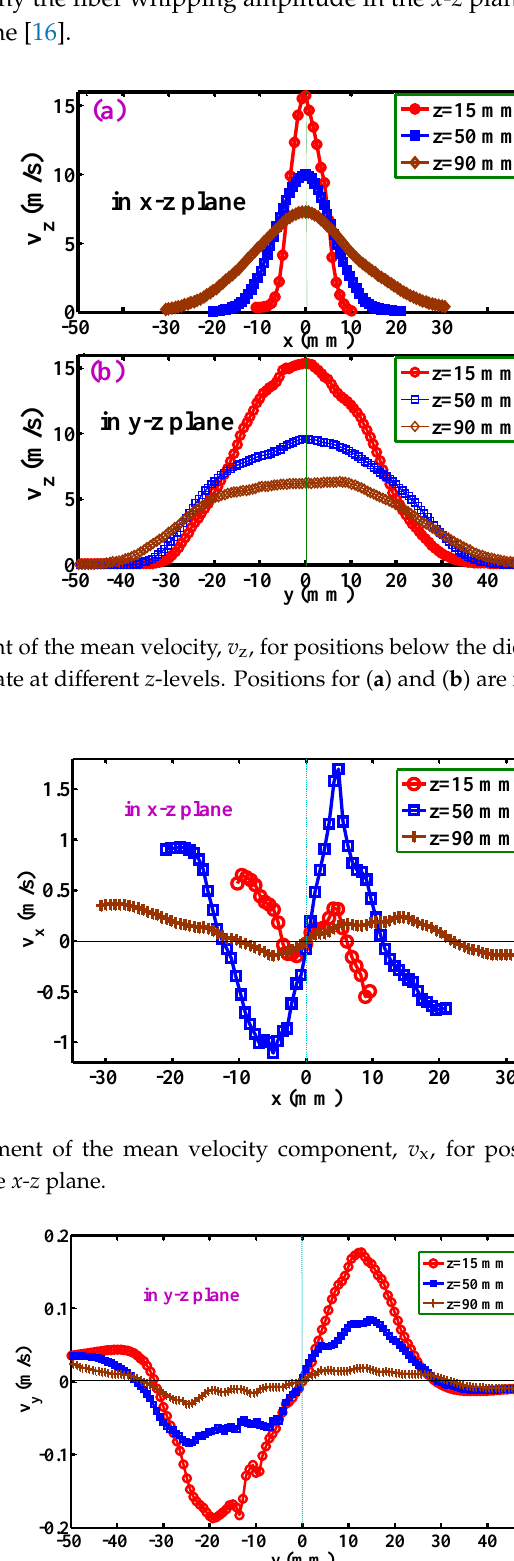
Figure 11. Development of the mean velocity component, v y , below the die face. All positions are in the y-z plane.